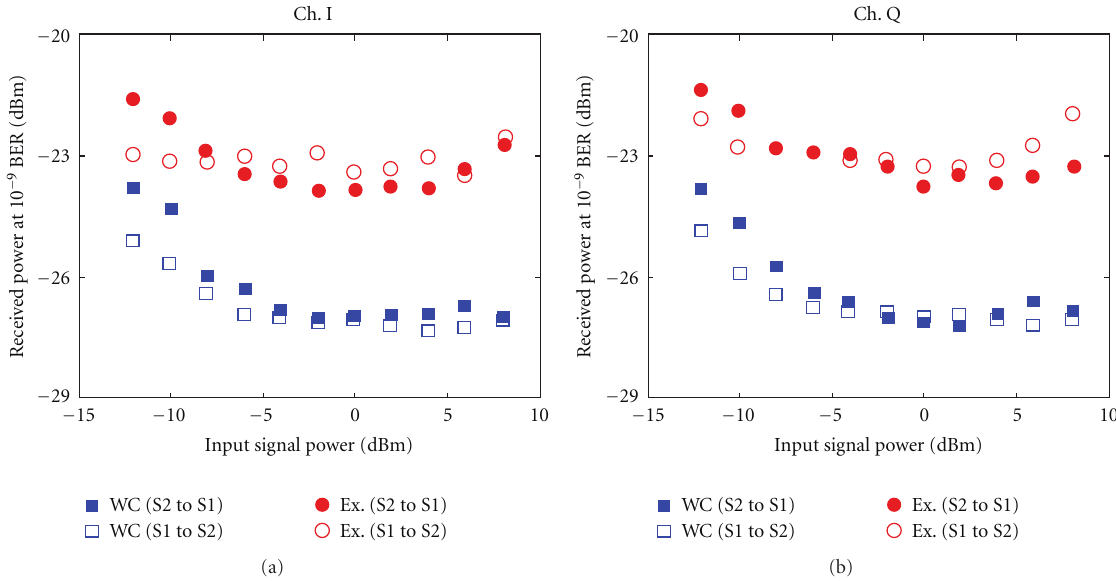
Figure 19: Dynamic range of the input signal power for 100 Gbit/s DQPSK data exchange.